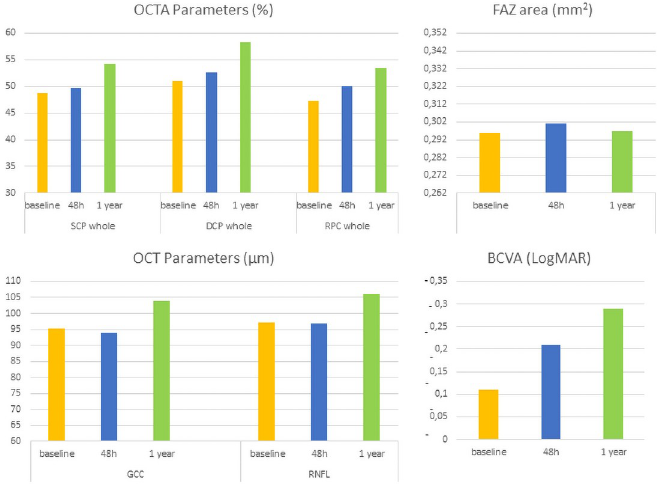
Fig 1. Schematic graphs of OCT and OCTA parameters measurements, and best corrected visual acuity (BCVA) at baseline, at 48 hours after surgery, and at 1-year post-surgery.